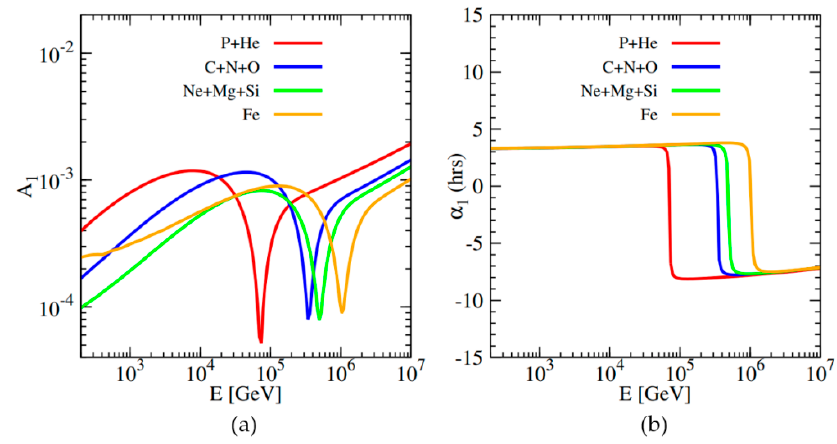
Figure 5. The amplitude ( a ) and phase ( b ) of the dipole anisotropy for four different mass groups P + He, C + N + O, Ne + Mg + Si, and Fe, respectively.